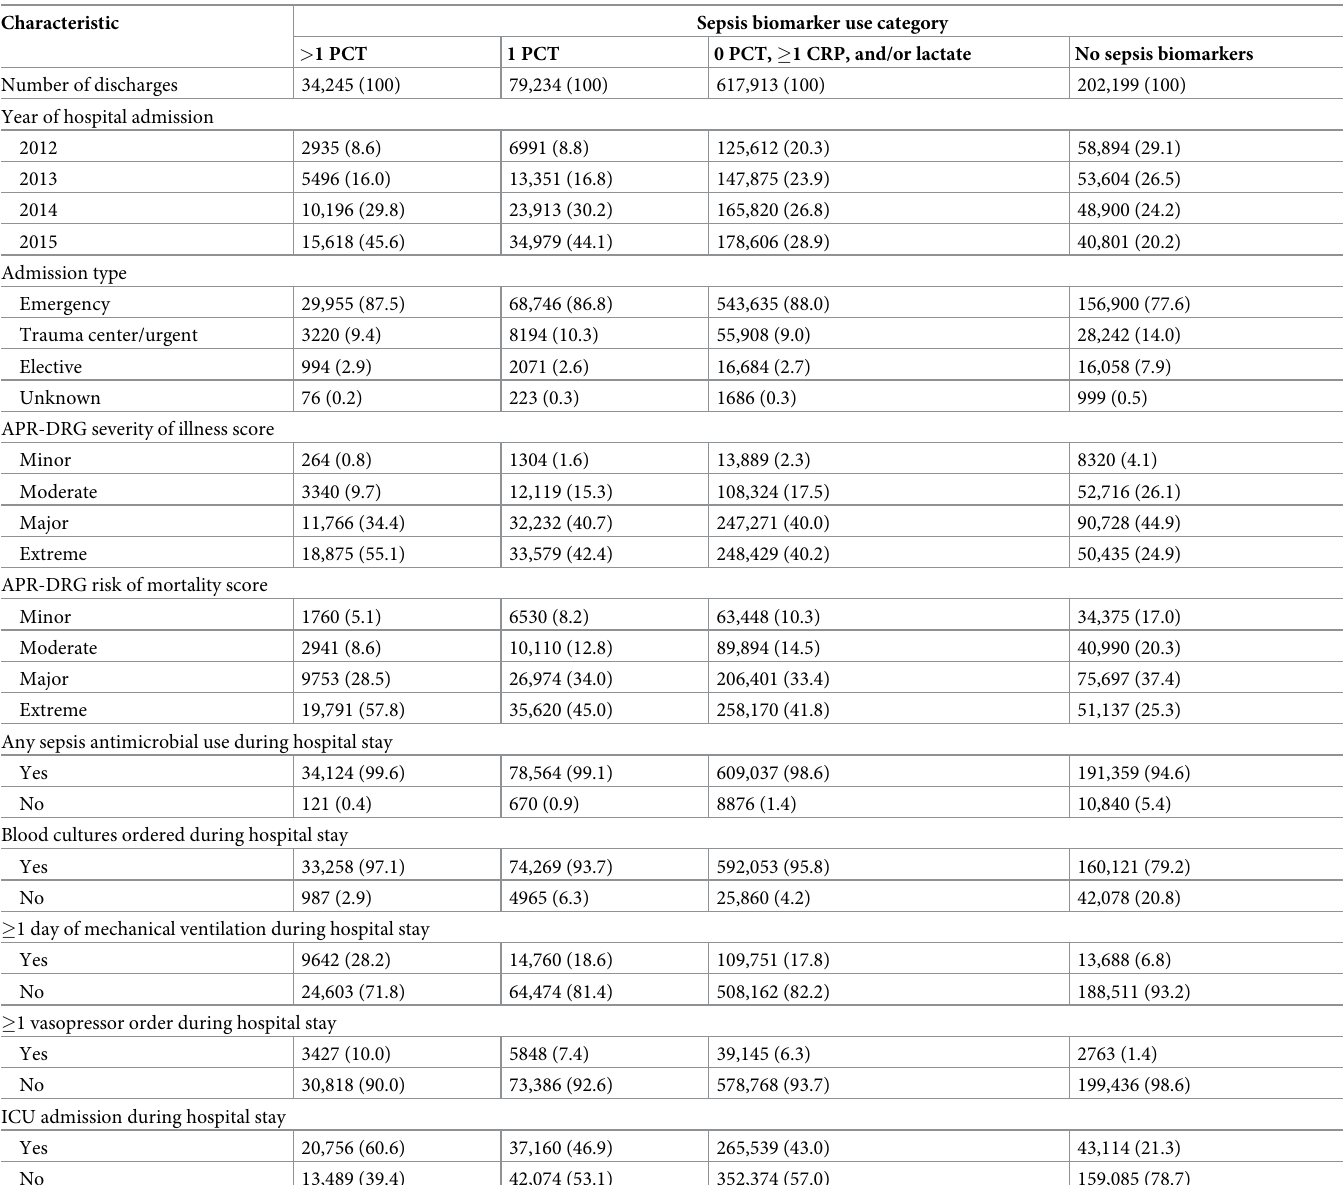
Table 3. Clinical characteristics for the overall study population (N = 933,591).